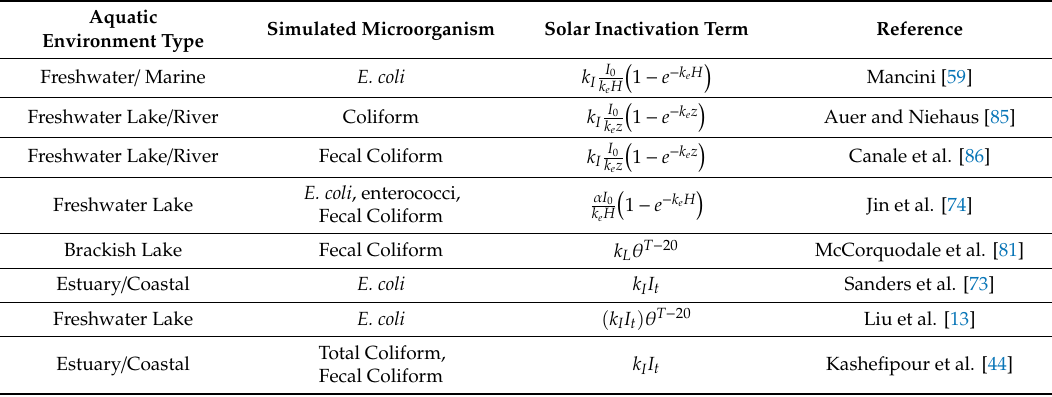
Table 2. Solar inactivation terms used in contaminant fate and transport